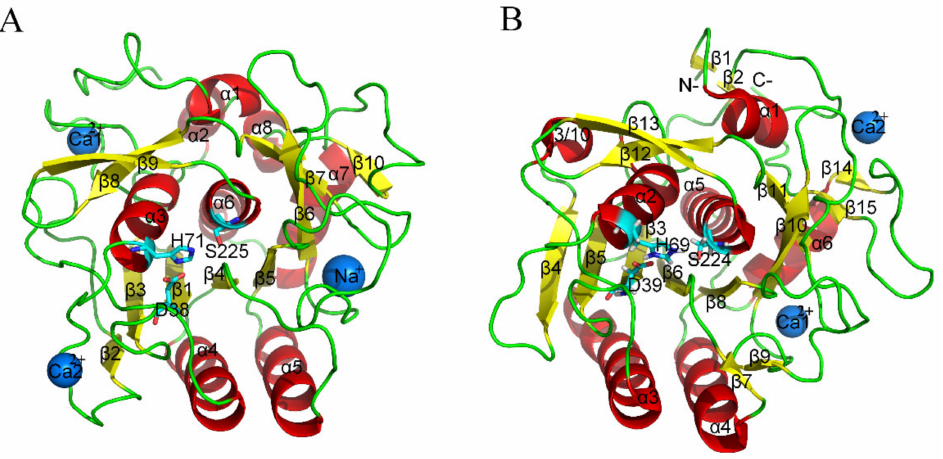
Figure 1. Ribbon representation of thermophilic ( A ) and mesophilic ( B ) serine proteases. These structures were obtained from PDB with PDB codes 1THM and 1IC6. α -helices, β -strands, and loops are colored red, yellow, and green, respectively. The catalytic triad residues are shown as stick models. Ca 2 + and Na + are shown as blue spheres. ( A ) and ( B ) were generated using Pymol